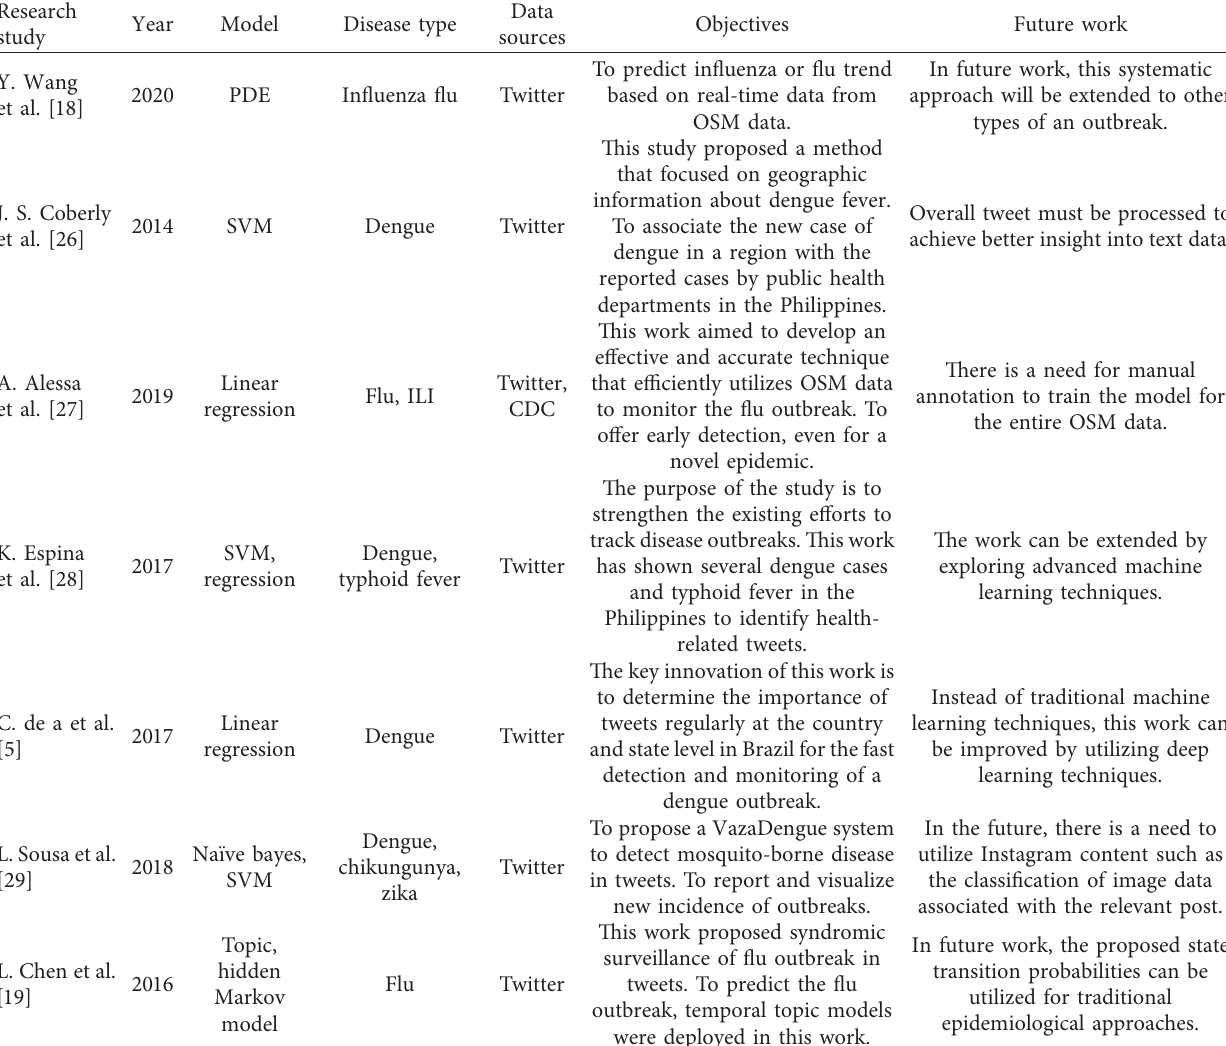
Table 1: Relevant research studies on outbreak detection using machine learning